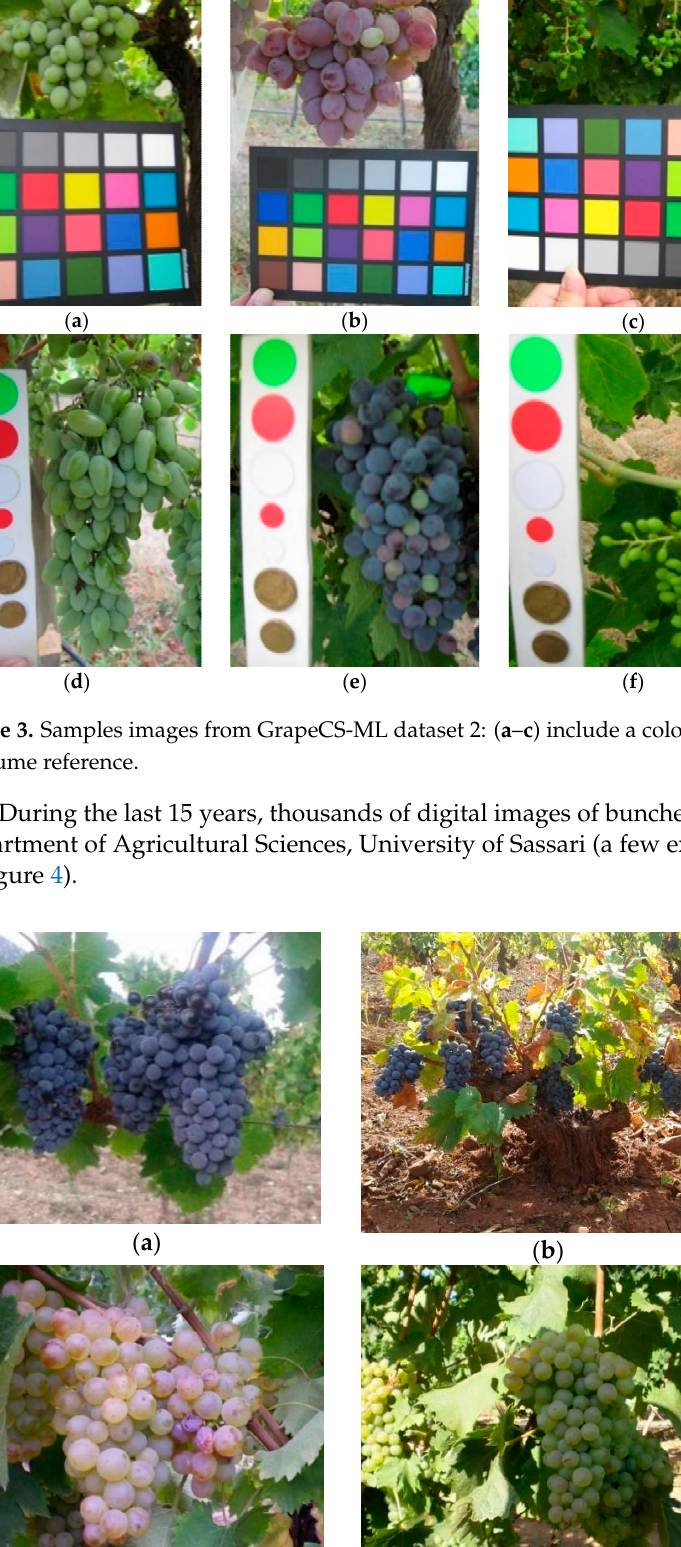
Figure 4. Samples images from our internal dataset: ( a ) cv. Cannonau; ( b ) cv. Cagnulari; ( c , d ) cv. Vermentino with different stage of maturation.